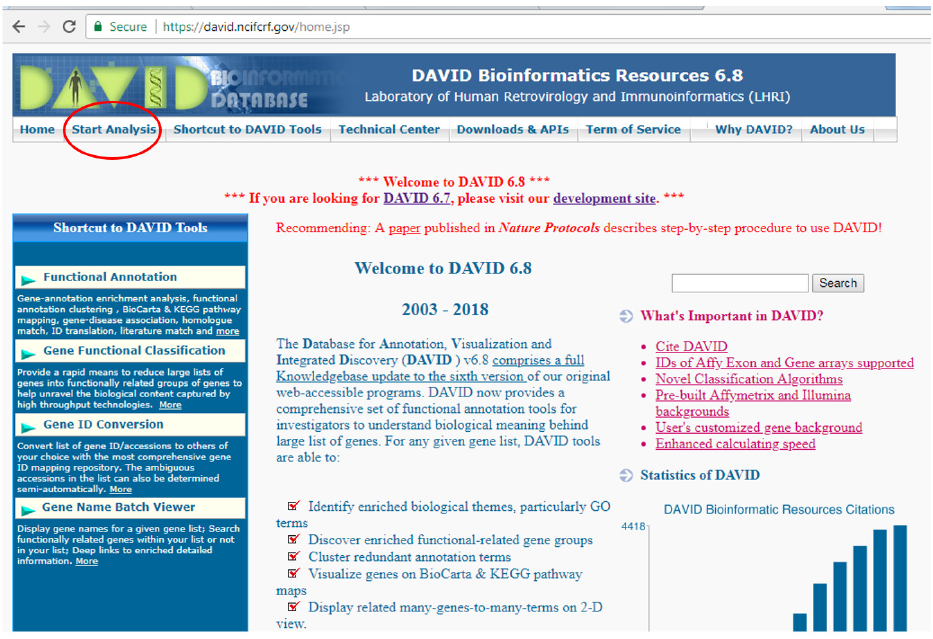
Figure 2. DAVID landing page. Screenshot of the DAVID landing page containing a brief description of the site and links for available tools. The “start analysis” button is circled in red and is located at the top left side of the page. This is the first step in submitting a geneset for analysis with GO Terms in DAVID.